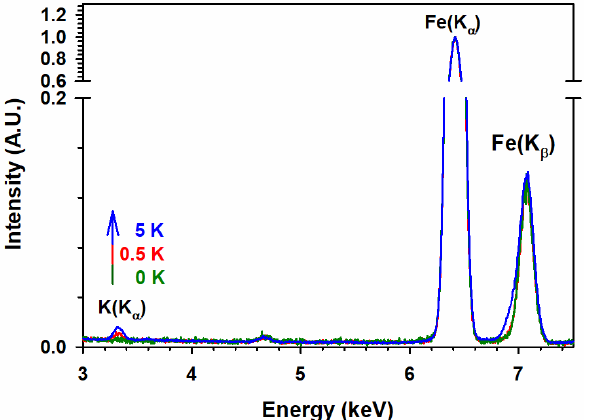
Figure 11. Energy-dispersive X-ray spectroscopy (EDS) spectra of 100 Fe: x K materials for potassium contents ( x ) of (green) 0 K, (red) ½ K, and (blue) 5 K for the K (K α ) emission line.